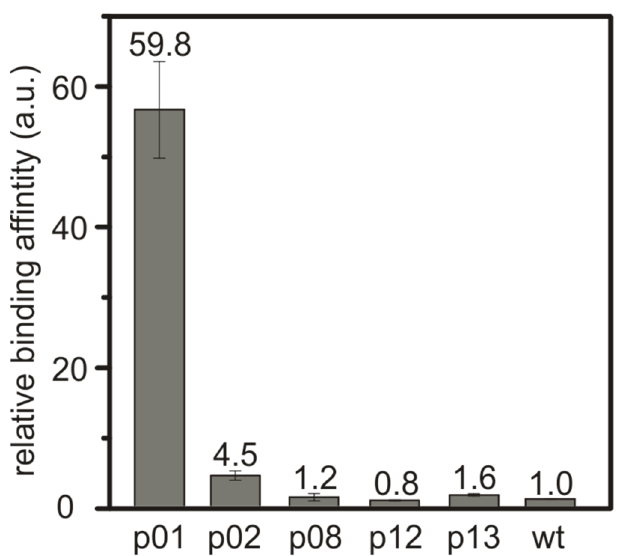
Figure 1. Relative binding strength of the M13 phage clones towards crystalline SnO powder with an average particle size of ~20 µ m. The phage clones presenting SnBP01 show a much higher binding affinity towards the SnO surface compared to the other selected peptides or unspecific binding M13 wild-type (wt) phages.